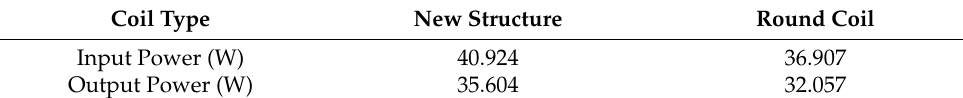
Table 2. Transmission power of each structure input and output when facing each other.